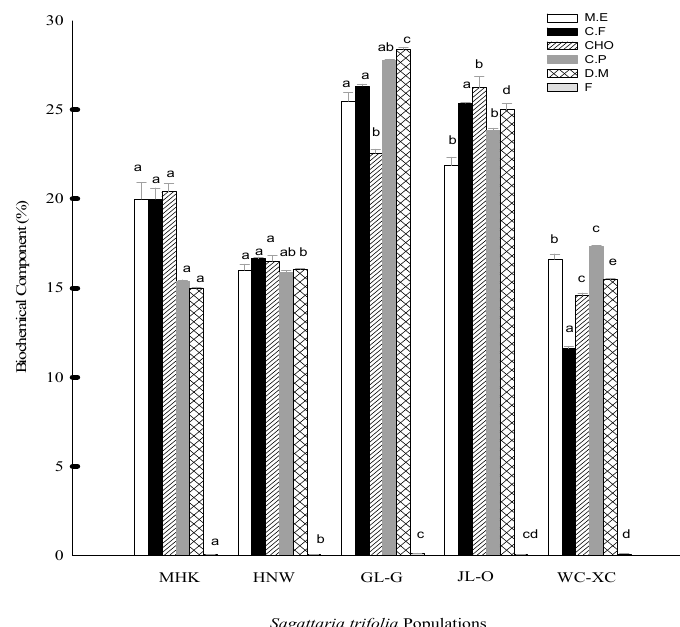
Figure 2. Biochemical composition of S. trifolia. Values are represented as the mean ± standard error. The same letters on bars indicated that the values are not significantly di ff erent according to the Tukey’s HSD test at p ≤ 0.05. M.E (mineral element); C.F (crude fibre), CHO (carbohydrates), C.P (crude protein), D.M (dry matter / ash), F (Fats); MHK (Meihekou), GL-G (Jilin), JL-O (Siping), HNW (Harbin), WC-XC